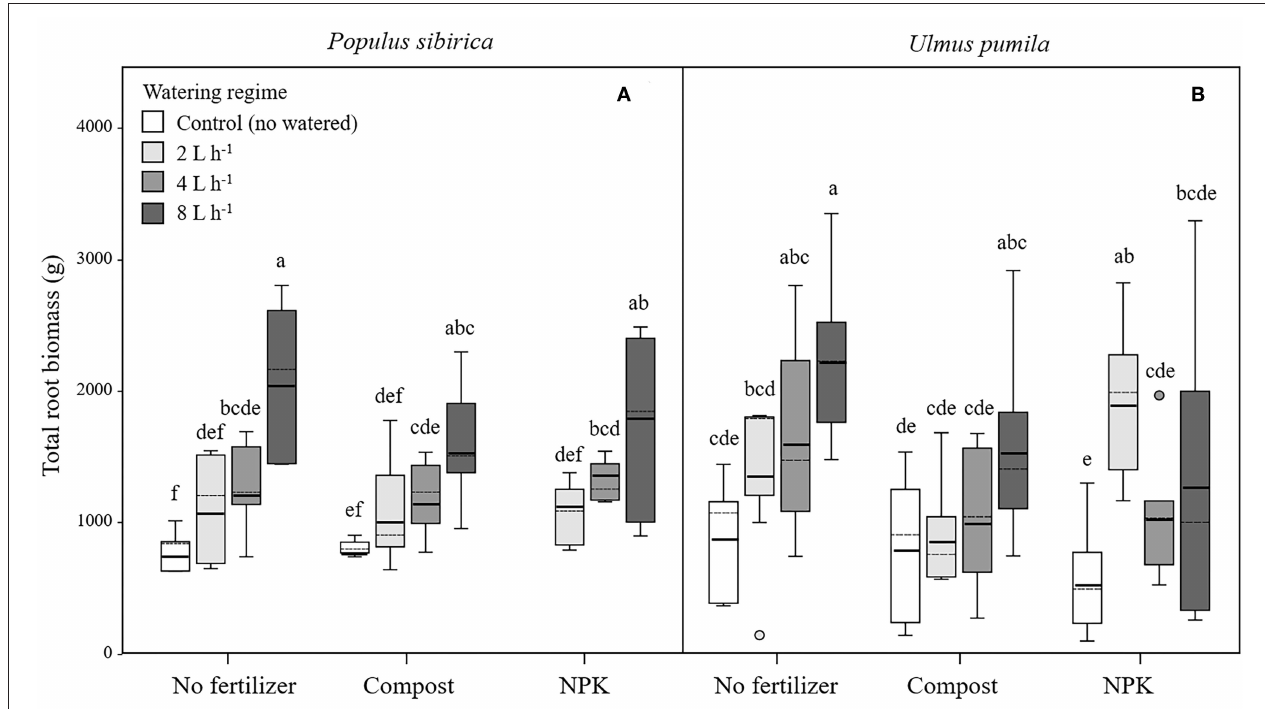
FIGURE 5 | Total root biomass for P. sibirica (A) and U. pumila (B) for different watering regimes and by different fertilization treatments. Different letters indicate significant differences ( p < 0.05) among watering regimes within each fertilization treatment. Vertical boxes represent ∼ 50% of the observations and lines extending from each box are the upper and lower 25% of the distribution. Within each box, the solid horizontal line is the mean value and the dotted line is the